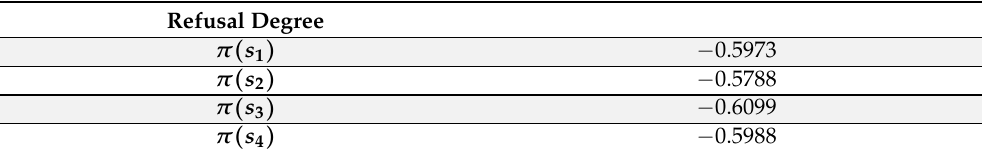
Table 18. Calculated values of Refusal degree.